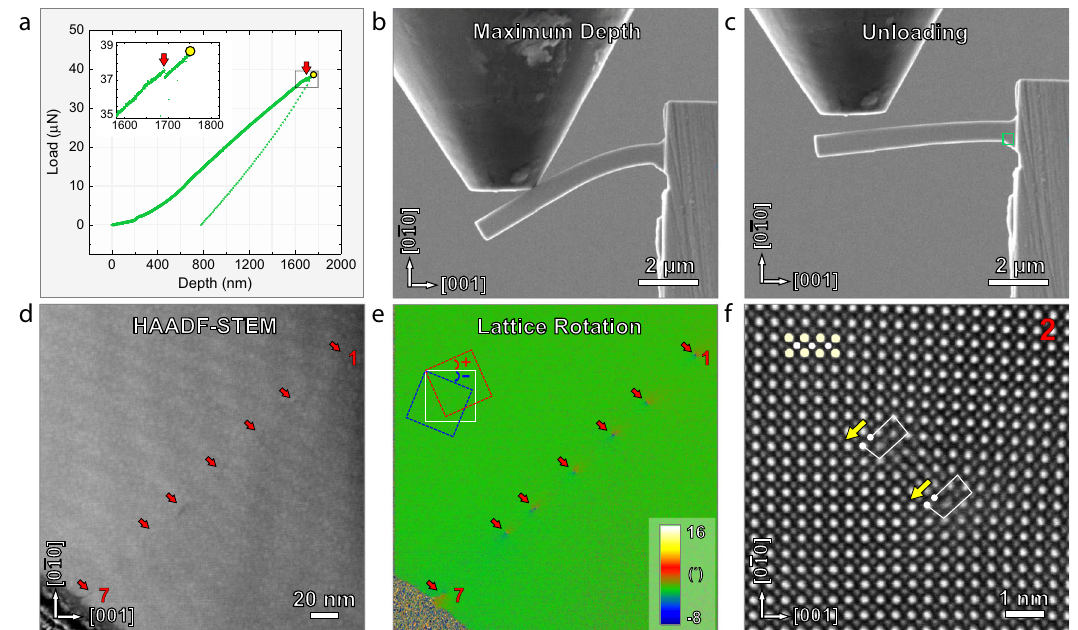
Fig. 2 Bending test of PIN-PMN-PT. a A load-depth curve obtained during bending a cantilever beam along a loading direction of [010]. The inset shows the enlarged curve of the rectangular area, where an abrupt decrease in mechanical load is evident. b Snapshot captured from in-situ video corresponding to the maximum depth of the indenter. c An SEM image showing cantilever beam after unloading. Irreversible deformation can be clearly revealed by comparison with Supplementary Fig. 2g. d – e A STEM-HAADF image and the corresponding GPA analysis of lattice rotation, with dislocations indicated by red arrows. Dislocations #1 and #7 are labelled. The lattice rotation angle is indicated by the color bar. f High-resolution STEM-HAADF images showing a [01 (cid:1) dislocation #2, which includes a pair of partial dislocations with Burgers vector of 1 2